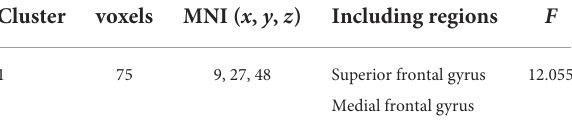
TABLE 2 Brain regions exhibiting global FCD aberrance among the three groups.